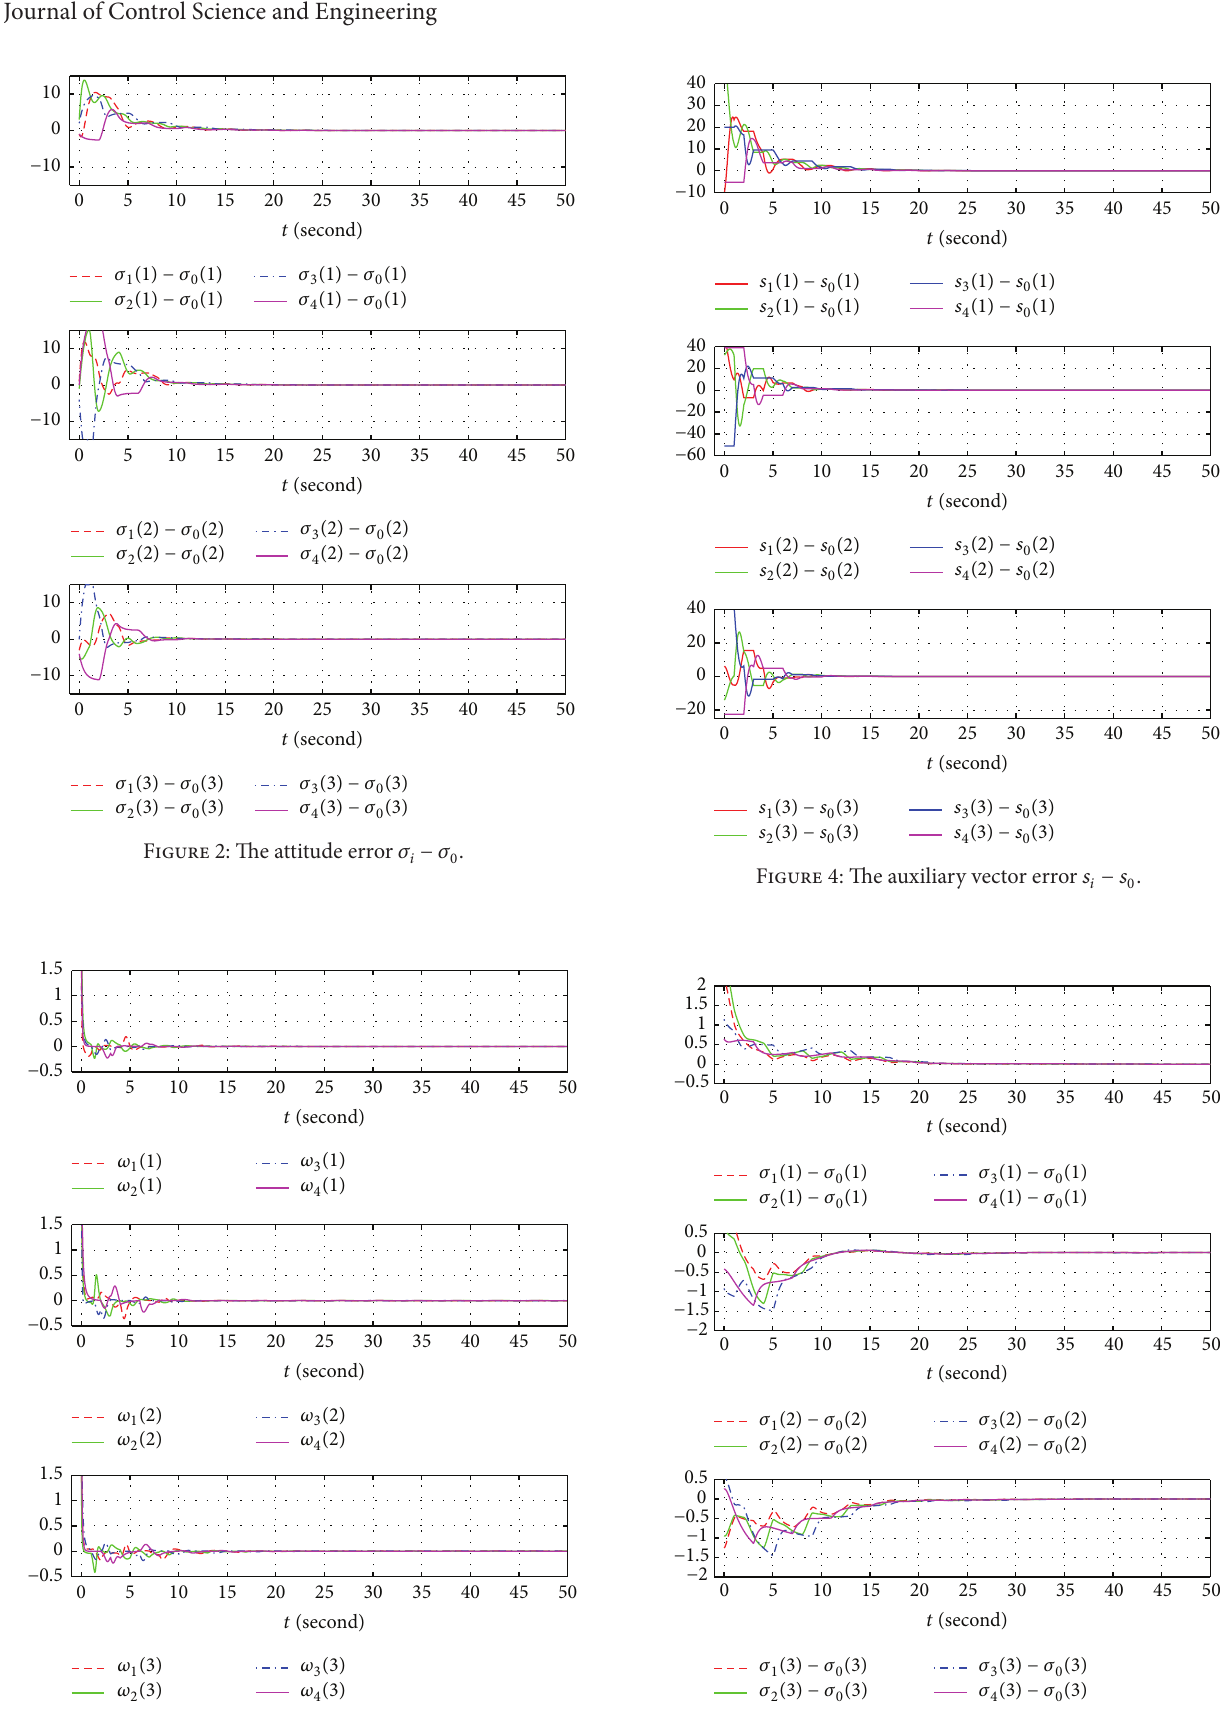
Figure 3: The angular velocity 𝜔 𝑖 .